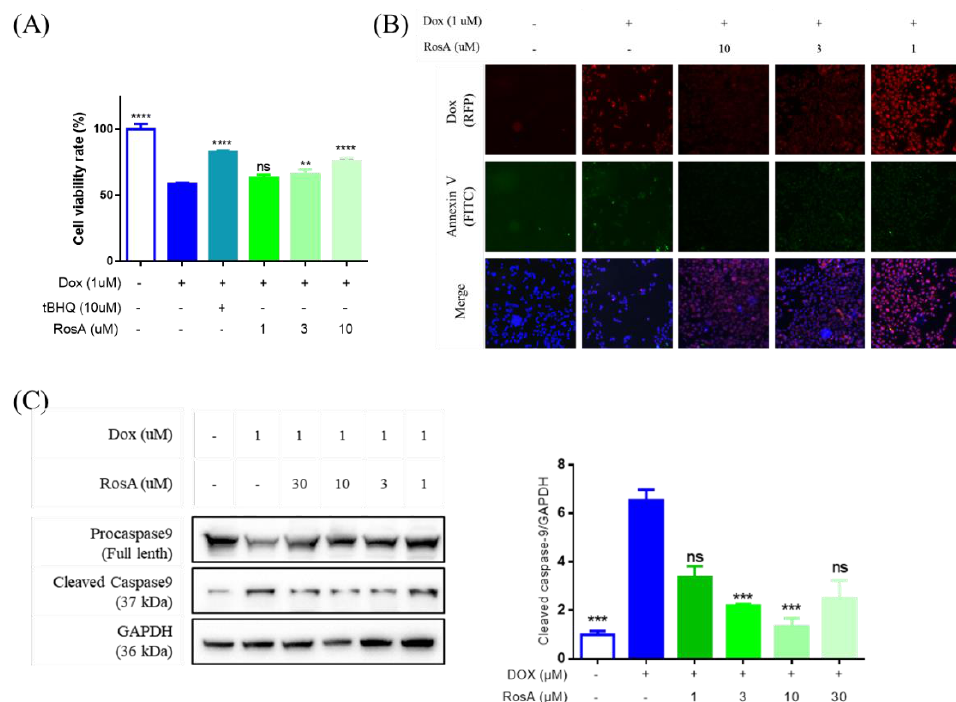
Figure 5. Effect of RosA on Dox-induced AC16 cell apoptosis. ( A ) The cell viability of RosA-pretreated cells after Dox treatment for 24 h. ( B ) The green fluorescence is Annexin V-FITC staining positive cells, and the red fluorescence is Dox staining positive cells. The blue fluorescence is Hochest 33342 staining positive cells. Apoptotic cells were stained by green and blue fluorescence, while normal cells were stained only by blue fluorescence. ( C ) Cleaved Caspase-9 was measured by Western blot analysis in AC16 cells after treatment. GAPDH was used as an internal control. * p < 0.05, ** p < 0.01, *** p < 0.001, **** p < 0.0001, ns: no significant difference. 1 μM Dox -treated was the model group; 0.25% DMSO-treated was the negative control group, compared with the model group. Results are expressed as mean ± SD ( n = 3).